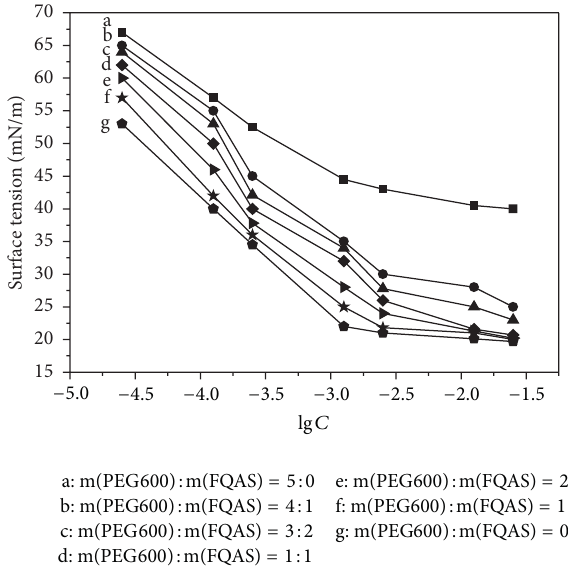
Figure 4: Effect of combination with hydrocarbon surfactant on surface tension of FQAS